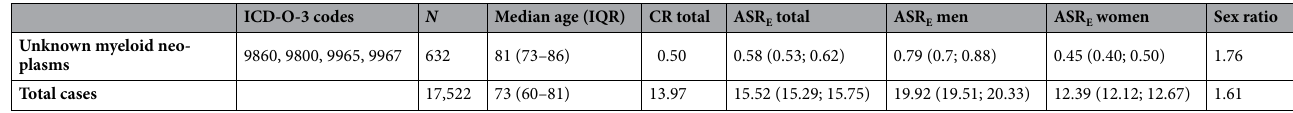
Table 2. List of ICD-O-3 codes included in the analysis, number of cases, median age and crude and age- standardized incidence rates of myeloid neoplasms diagnosed during 2002–2013 in Spain. IQR interquartile range, CR crude rate, ASR E Age-standardized rate (2013 European population), AML acute myeloid leukemia, MPN myeloproliferative neoplasms, MDS myelodysplastic syndromes, MN myeloid neoplasms, NOC not otherwise categorized, NOS not otherwise specified. Rates are expressed per 100,000